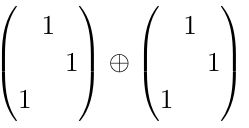
The orbits of VEVs of the corresponding potential of one triplet are identical to that of one triplet of (cid:1)(6 n 2 ), cf. eq. (3.77). The di(cid:11)erence to the previous potential lies in the fact that the full symmetries of V only allow for cyclic permutations, i.e. (cid:1)(3 n 2 )